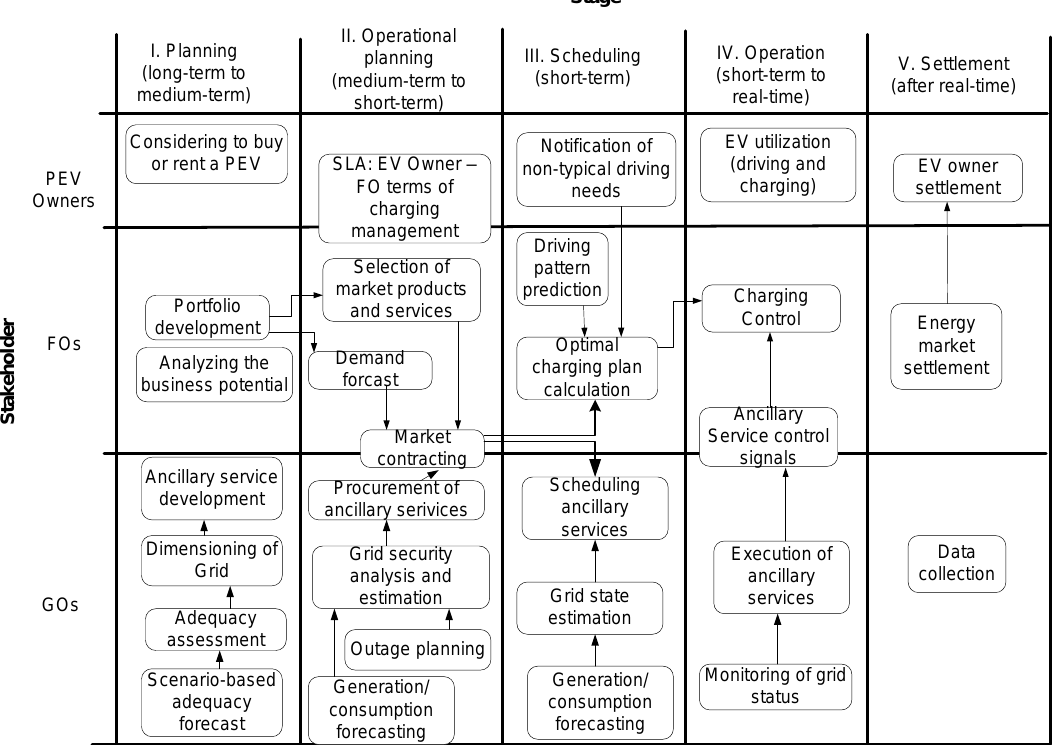
Figure 3. Schematic diagram of stage-based functional processes for EV owners, FOs, and grid operators (GOs) (adapted from [21]).